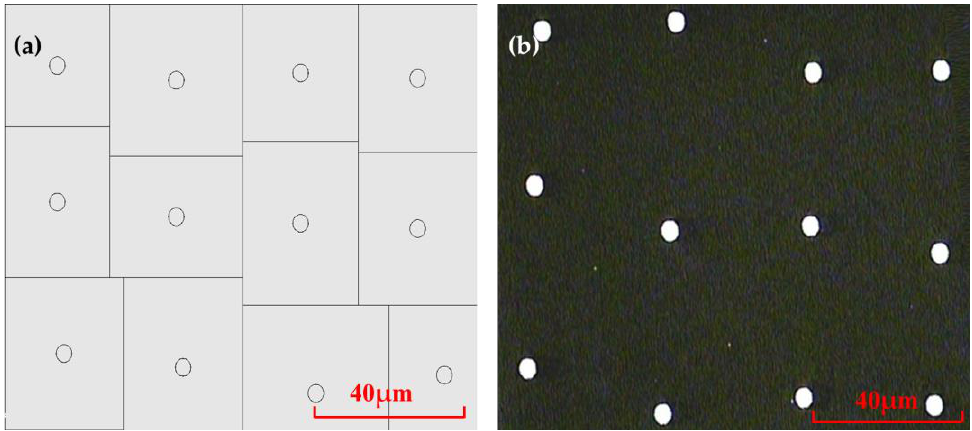
Figure 7. Mask part pattern: ( a ) rectangular randomly arranged mask data; and ( b ) microscopy pattern of mask made by laser direct writing technology.